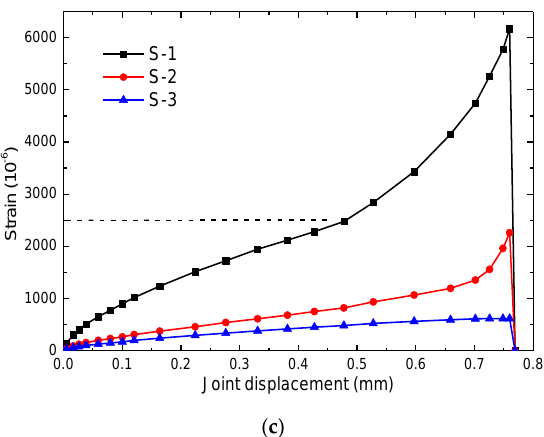
Figure 9. Strain development during quasi-static tensile tests. ( a ) Reference specimen; ( b ) WD-90-60; ( c ) HY-90-60.